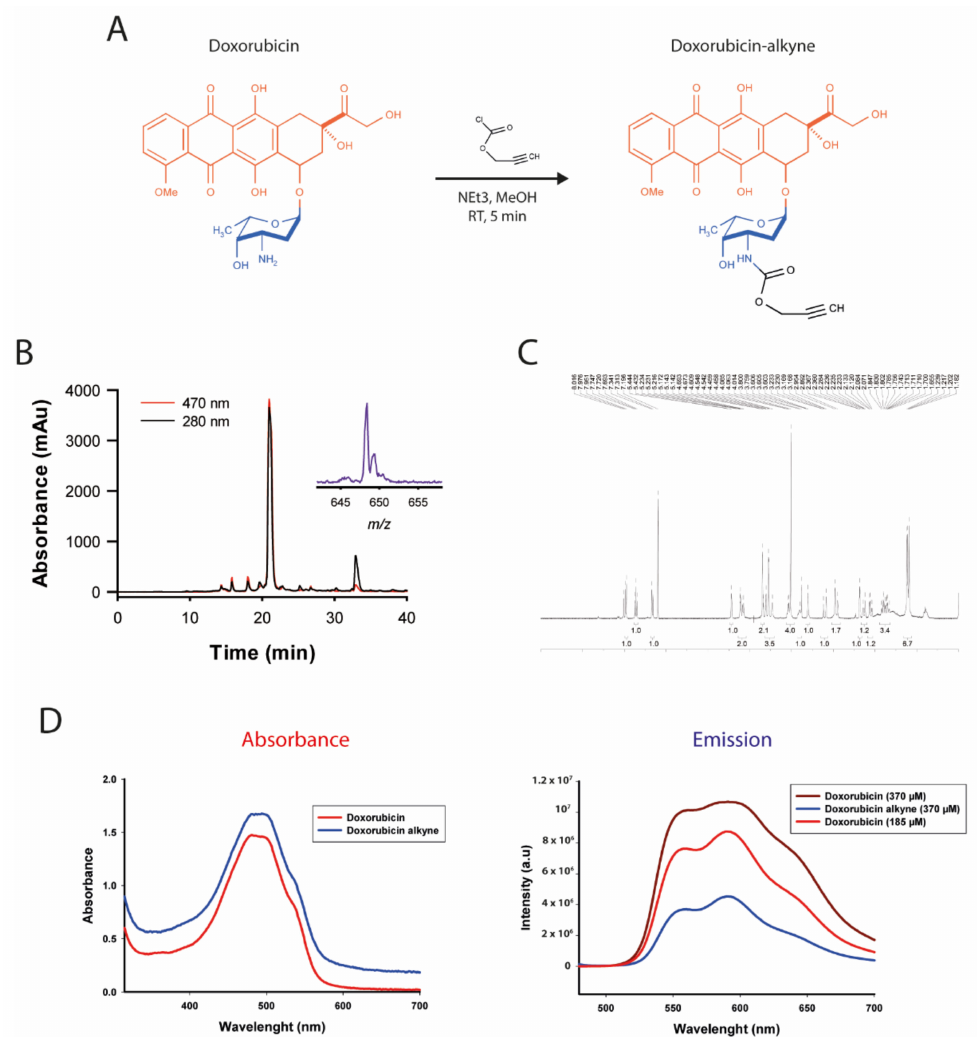
Figure 4. Synthesis and characterization of doxorubicin-alkyne. ( A ) Chemical synthesis of doxorubicin-alkyne. The aglycone moiety is shown in orange, while the daunosamine moiety is represented in blue. ( B ) RP-HPLC purification and mass spectra characterization of doxorubicin- alkyne. ( C ) 1 H-NMR characterization of doxorubicin-alkyne. ( D ) Spectral properties of doxorubicin and